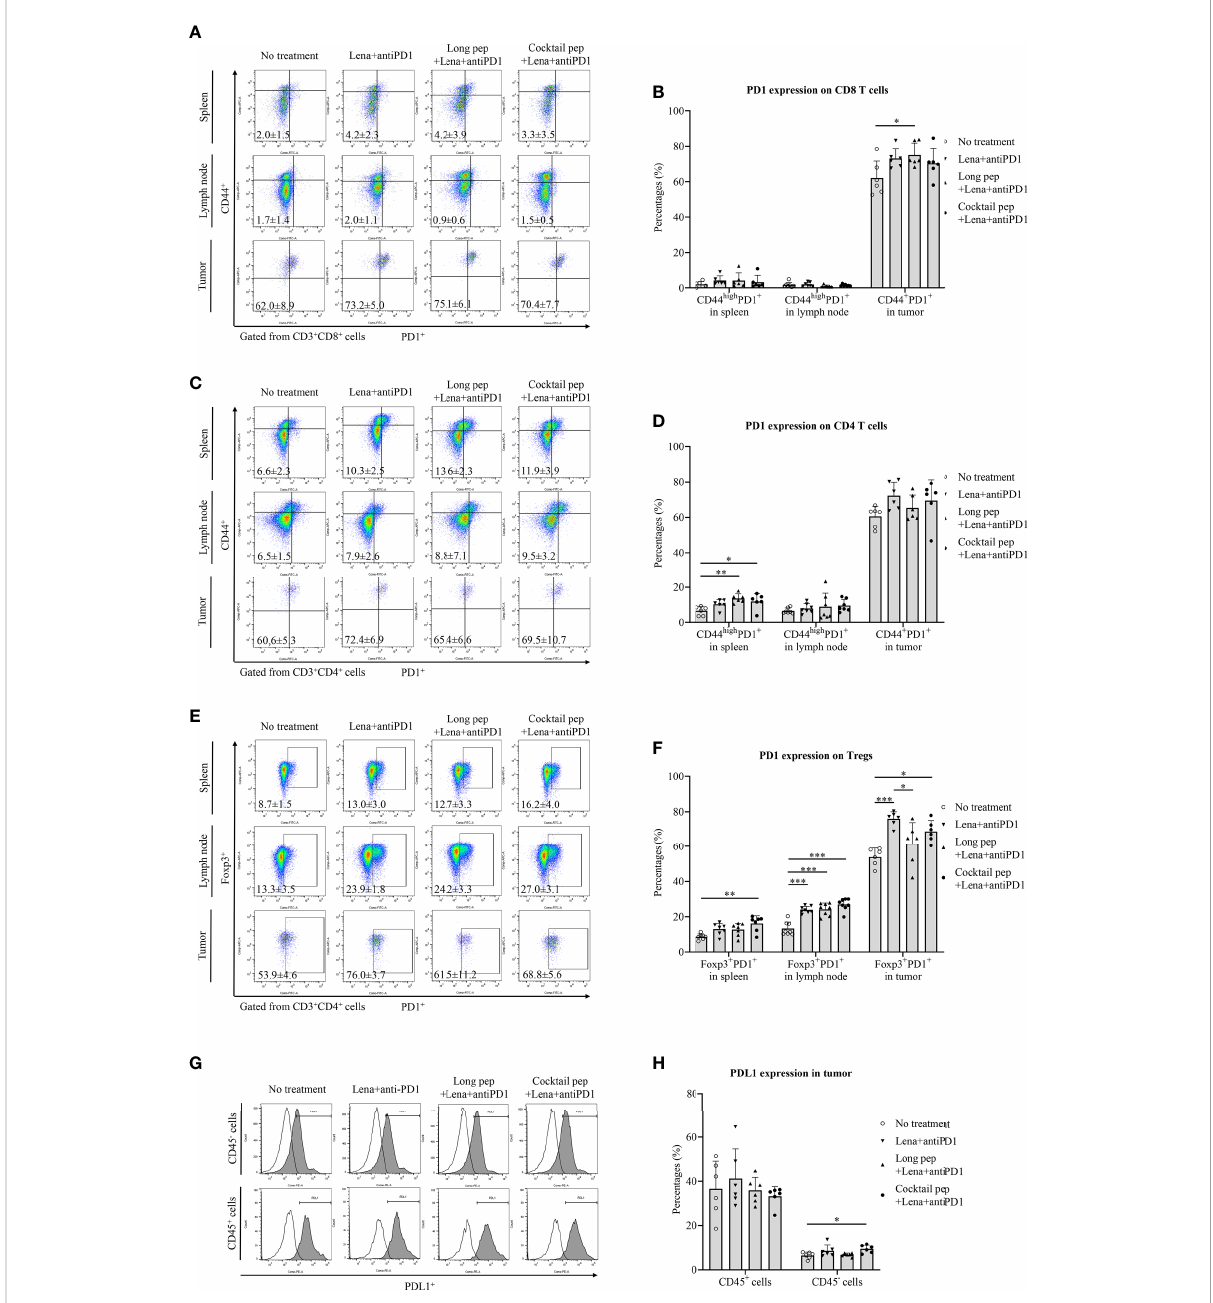
FIGURE 3 The expression of the inhibitory marker (PD1) and its ligand (PDL1) in immune cells and single tumor cells was con fi rmed by fl ow cytometry. The expression of PD1 in effector CD8 + and CD4 + T cells was measured in the spleens (n = 6 for each treatment group), lymph nodes (n = 7 for each treatment group), and tumors (n = 6 for each treatment group) (A-D) . The expression of PD1 in regulatory T cells (Tregs) in the spleens (n = 7 for each treatment group), lymph nodes (n = 8 for each treatment group), and tumors (n = 6 for each treatment group) was also measured (E, F) . The expression of PDL1 in immune and single tumor cells was measured (n = 6 for each treatment group) (G, H) . All data is shown as the mean ± standard deviation (SD). No treatment: no treatment group; Long pep: long multi-epitope peptide; Long pep+Lena: long multi-epitope peptide plus lenalidomide; Lena+anti-PD1: Lenalidomide plus anti-PD1; Long pep+Lena+anti-PD1: long multi-epitope peptide plus lenalidomide and anti-PD1; Cocktail pep+ Lena+anti-PD1: cocktail of multi-epitope peptide plus lenalidomide and anti-PD1. p< 0.05 (*), p< 0.001 (**), p< 0.0001